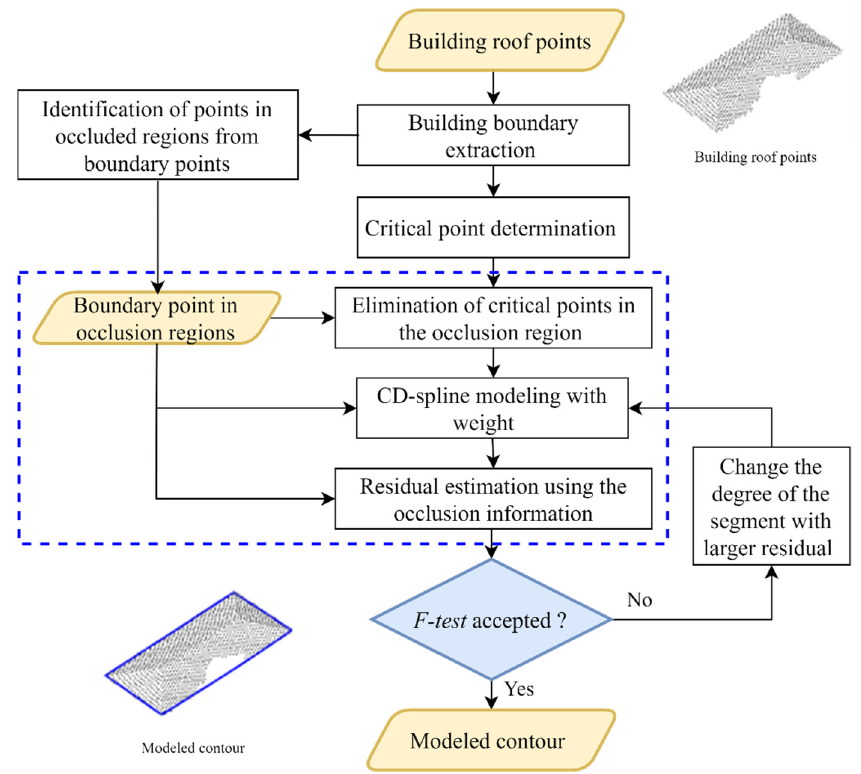
Figure 2. Flowchart of the proposed approach.